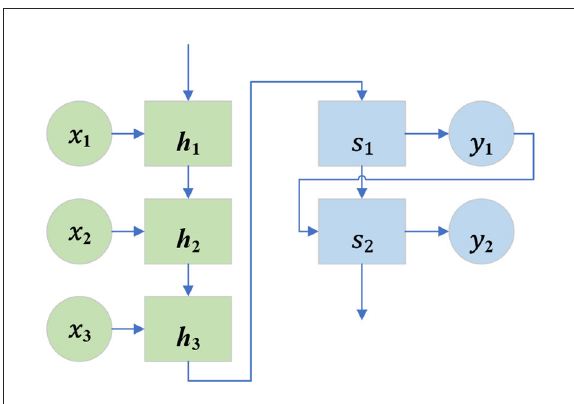
FIGURE3 Network structure of the Sequence-to-Sequence model.